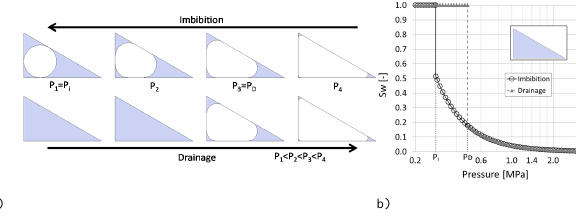
Figure 5. (a) Modeled distribution of water (gray) and gas (white) phases in a right-angled triangular capillary ( G = 0.39) with side lengths L = 1, 0.81, 0.58µm, and perimeter P = 2 . 39µm during imbibition (top) and drainage (bottom). (b) Water saturation versus capillary pressure during imbibition ( (cid:13) ) and drainage ( (cid:78) ).